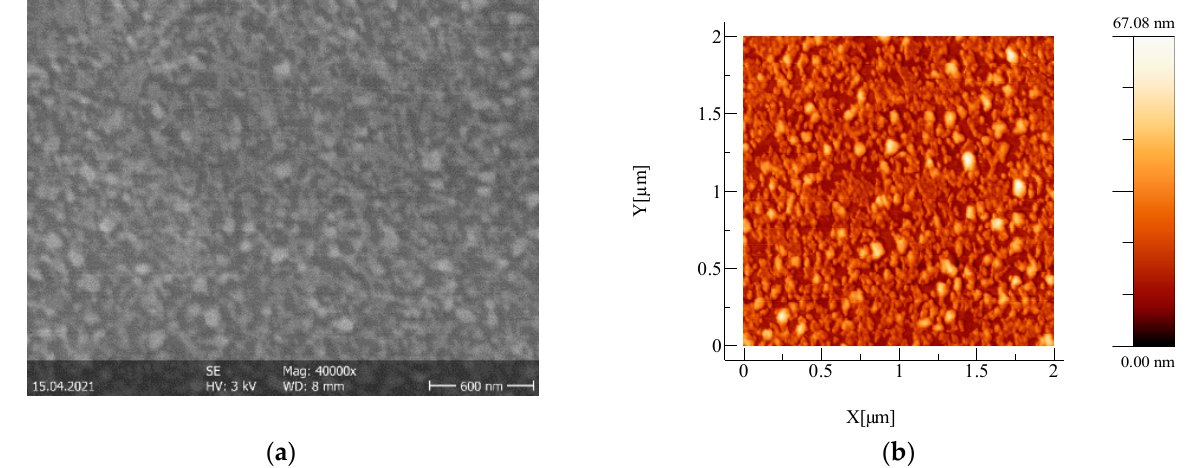
Figure 1. SEM micrographs of single oxide (bottom) layers: ( a ) TiO 2 , ( b ) TiO 2 :Nb and ( c ) NiO; and SEM micrographs of the top oxide layers of oxide/Ag/oxide multilayer structures: ( a’ ) TiO 2 , ( b’ ) TiO 2 :Nb and ( c’ ) NiO.